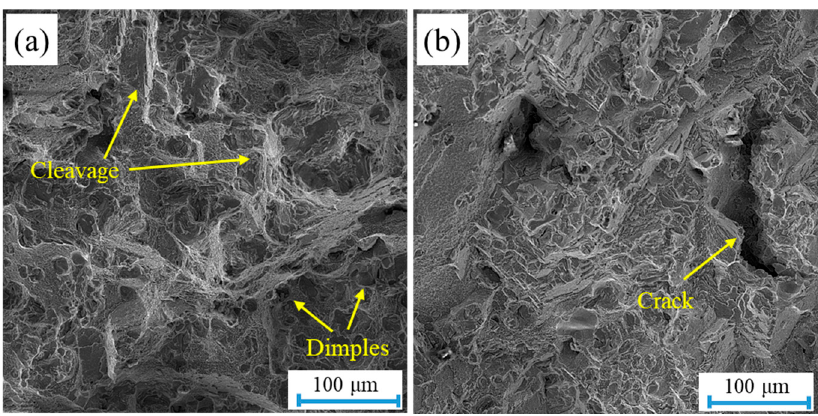
Figure 14. Fracture surface after tensile test: ( a ) BM and ( b ) A1 welded specimen.